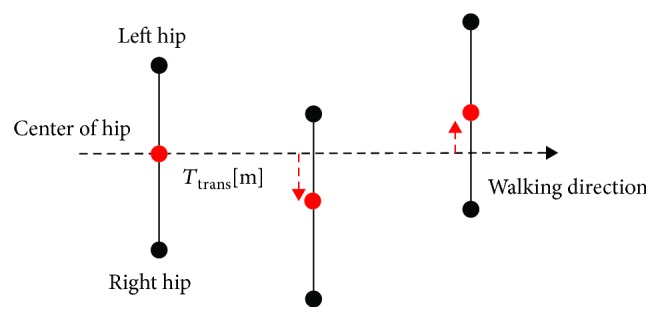
Definition of mediolateral movement, Ttrans.